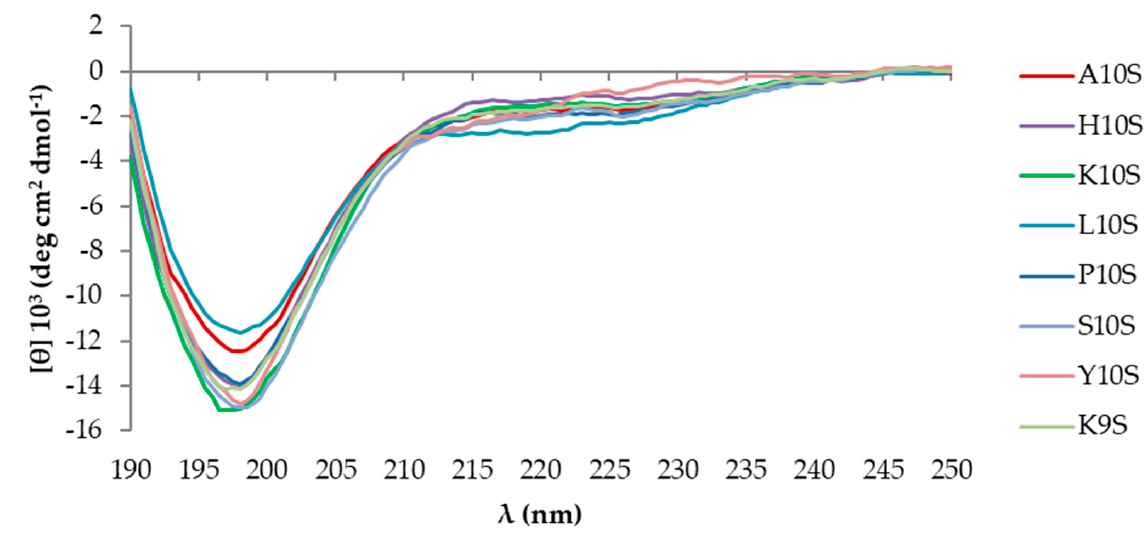
Figure 2. Far UV-CD spectra of 100 µM KP (A10S) and KP-derivatives acquired at 20 °C immediately after preparation of the starting aqueous solution (1 mM).